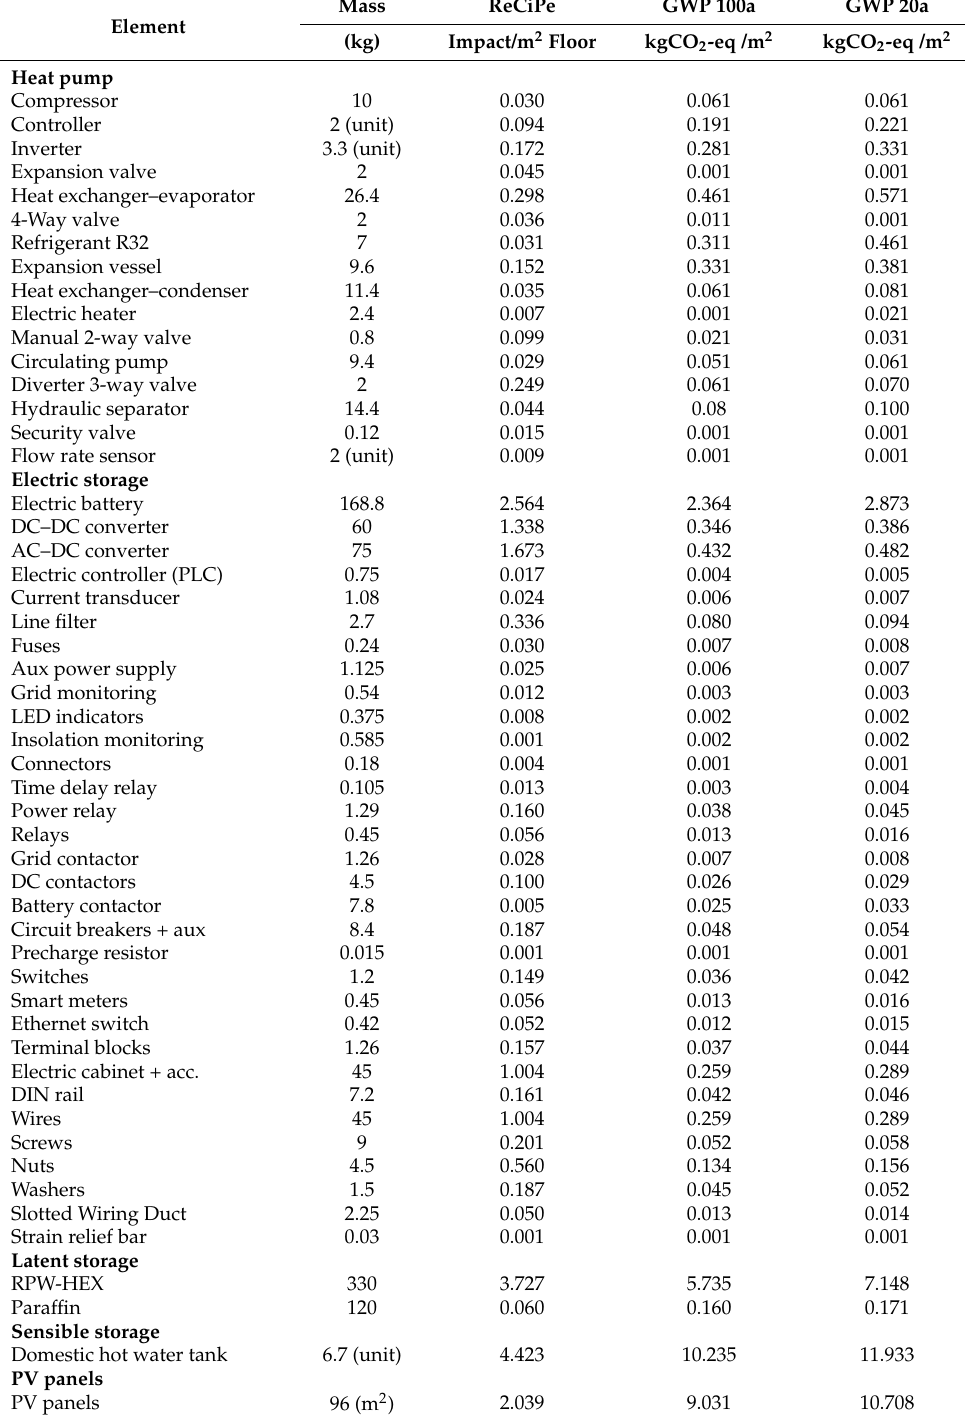
Table 8. LCIA of the innovative system during manufacturing/disposal